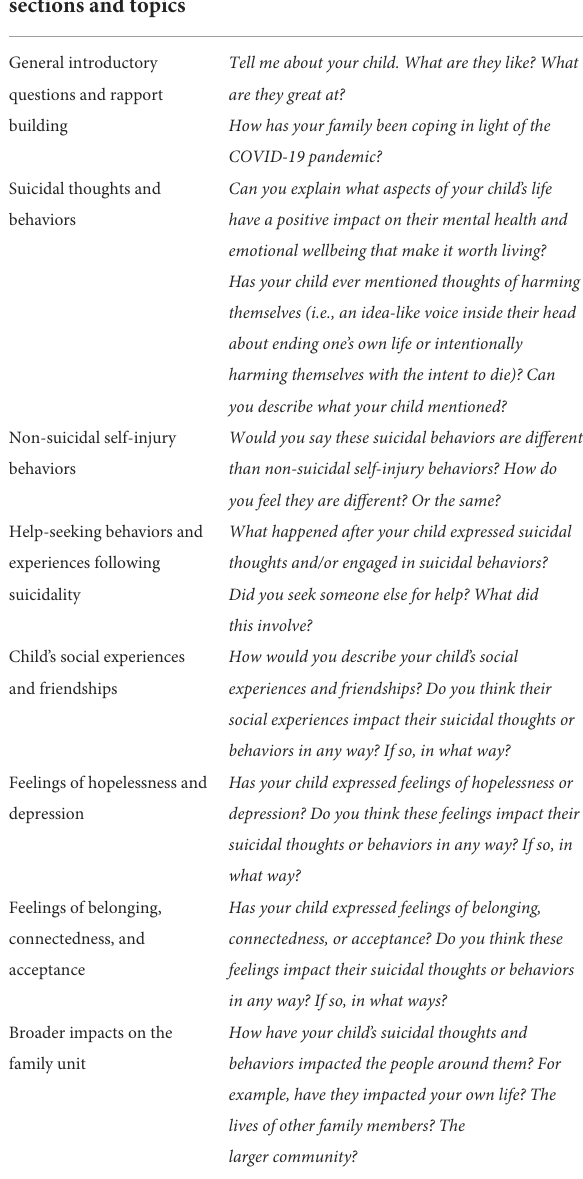
TABLE 1 Example interview guide